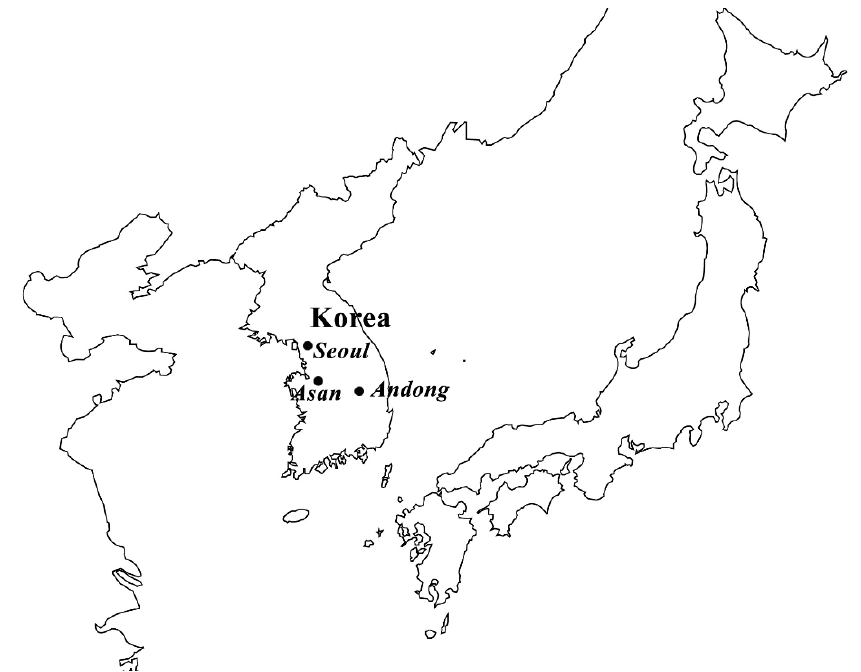
Figure 8. Location of Andong’s Hahoe Village and Asan’s Oeam Village (author’s drawing).